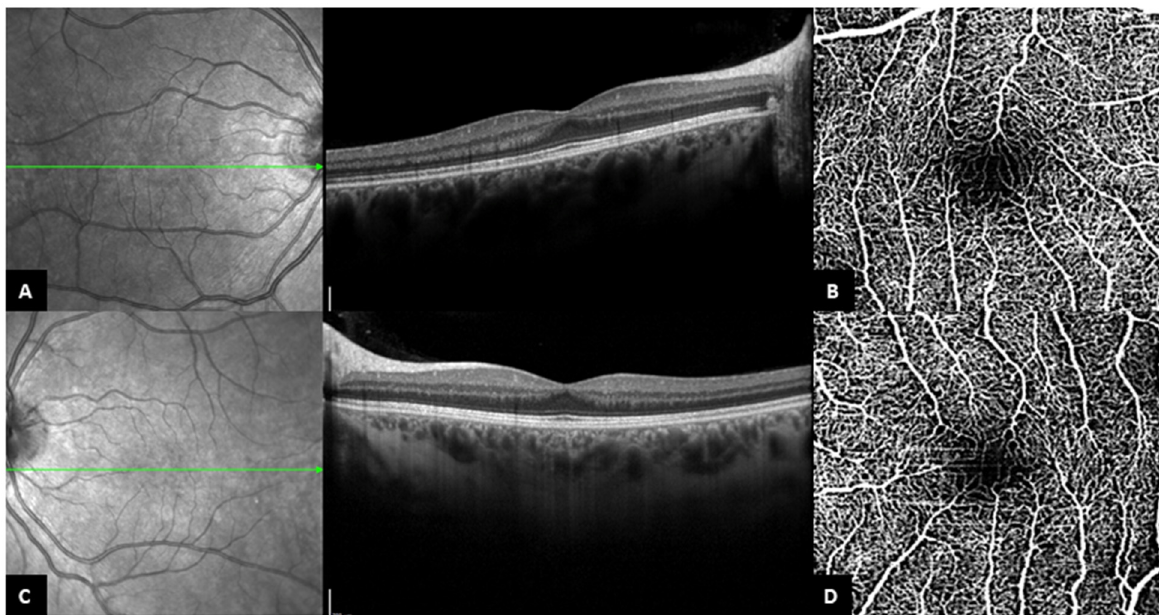
Figure 3. Patient 18. ( A , C ). Central OCT B-scan of the right eye and the left eye, with persistence of the inner retinal layers. ( B , D ). OCT-A from the same patient, (( B ). right eye, ( D ). left eye), with bridging vessels across the foveal avascular zone (the slabs contain the superficial and deep capillary plexuses together).